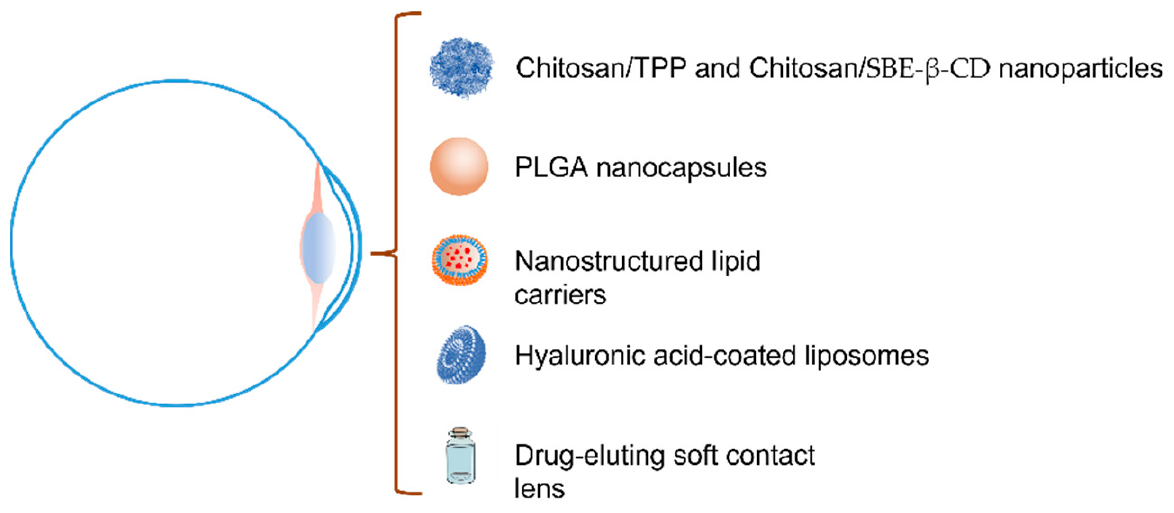
Figure 6. Different technologies used to improve the ocular drug bioavailability of lactoferrin.